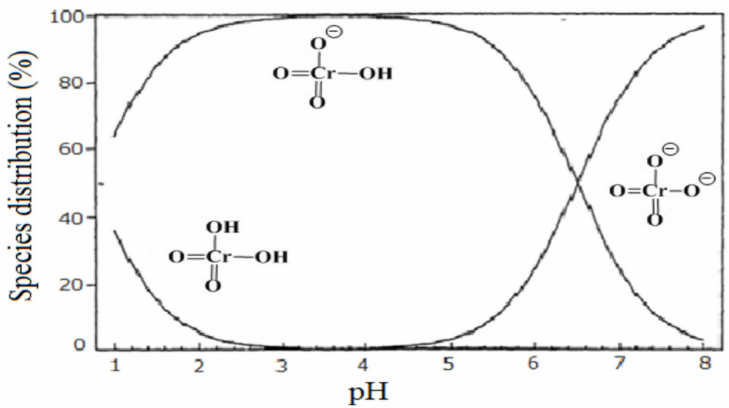
Figure 4. Species distribution curves of Cr(VI) in environmental water [32].